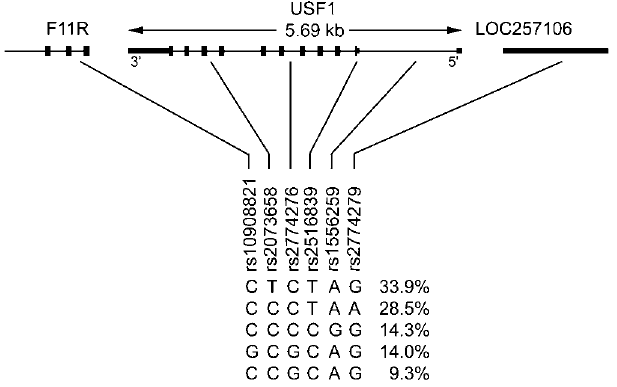
Figure 2. The Haplotype Structure in the USF1 Gene Locus The six genotyped SNPs from the USF1 gene locus resulted in five common haplotypes. The haplotype frequencies were calculated for the two FINRISK subcohorts combined. DOI: